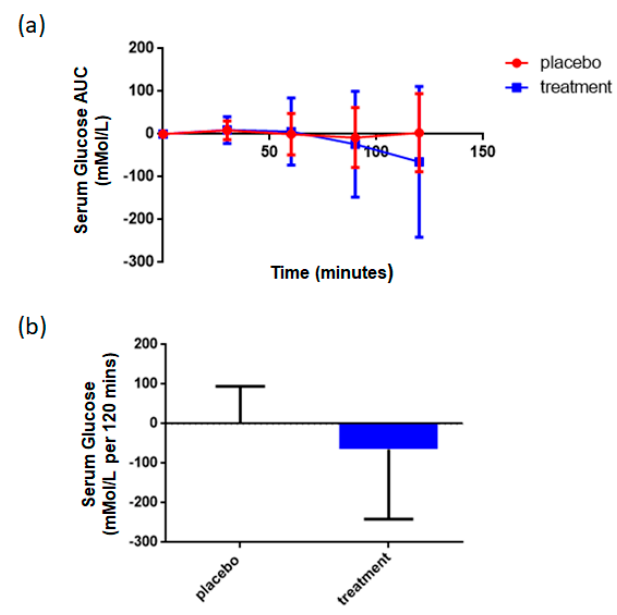
Figure 6. E ff ect of rice NPN supplementation on serum concentrations of glucose. ( a ) The total area under the curve (AUC) for serum glucose (mmol / l) at various intervals after the start of consumption of either placebo or rice NPN (treatment), starting with “0” at t = 0. Each point represents the mean value + 1 x +/ − standard deviation of at least 9 observations in placebo and at least 24 in rice NPN group. ( b ) Change in total area under the curve (per 120 min) with respect to the difference in outcome between visits 2 and 5. No outliers removed. Each symbol represents the mean + 1 x +/ − standard deviation of 9 persons (in placebo) or 24 persons (in rice NPN group).